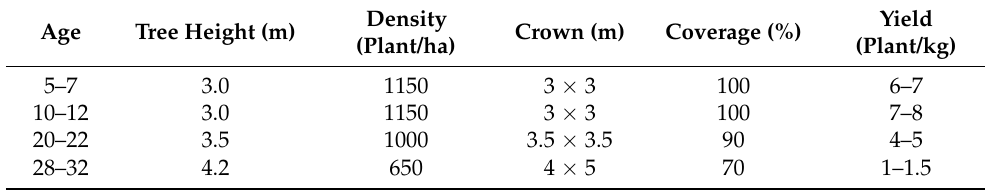
Table 1. Basic characteristics of